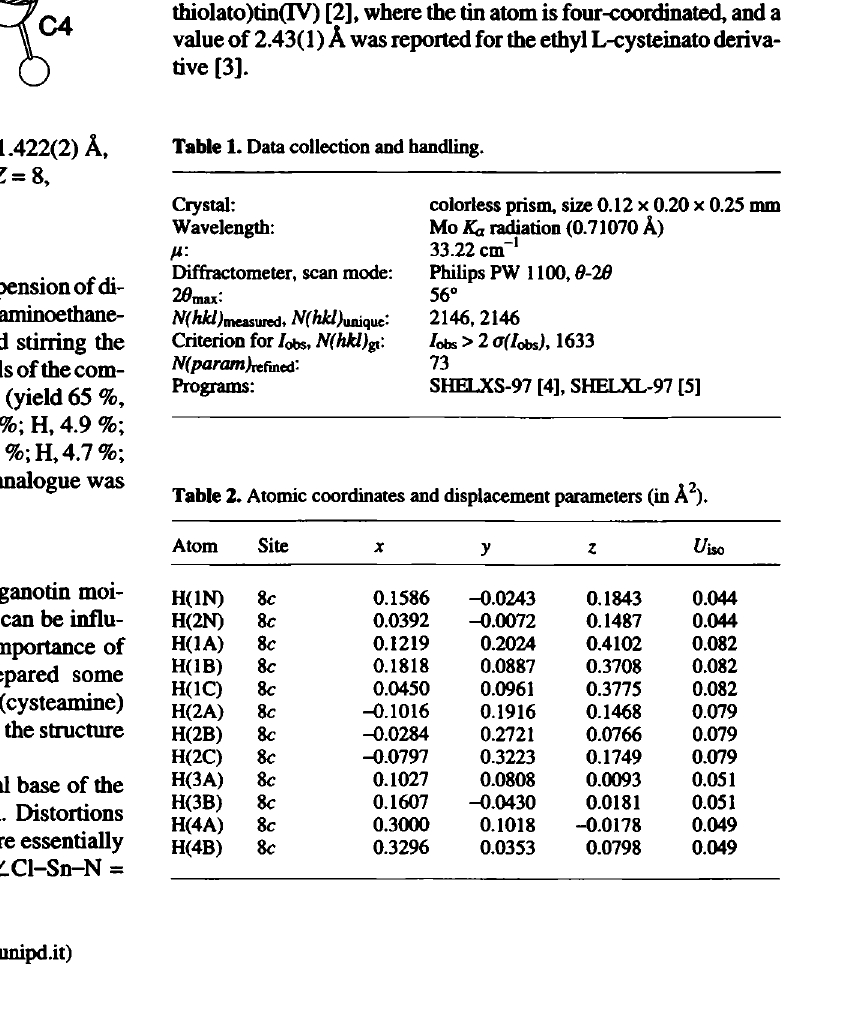
Table 1. Data collection and handling.